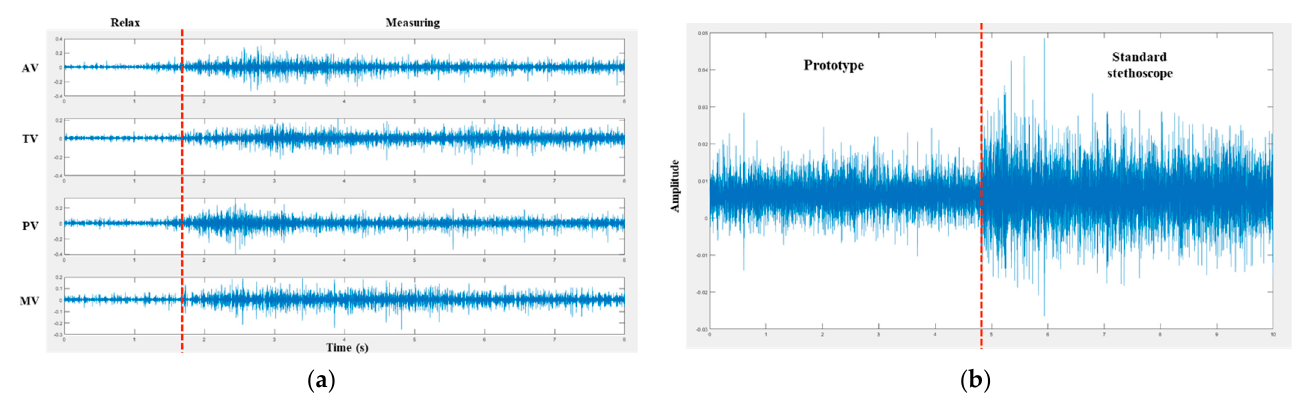
Figure 7. Example of EMG signals in performance and usability tests: ( a ) EMG signals for heart sound at four measurement positions; ( b ) EMG signals comparison between prototype and standard